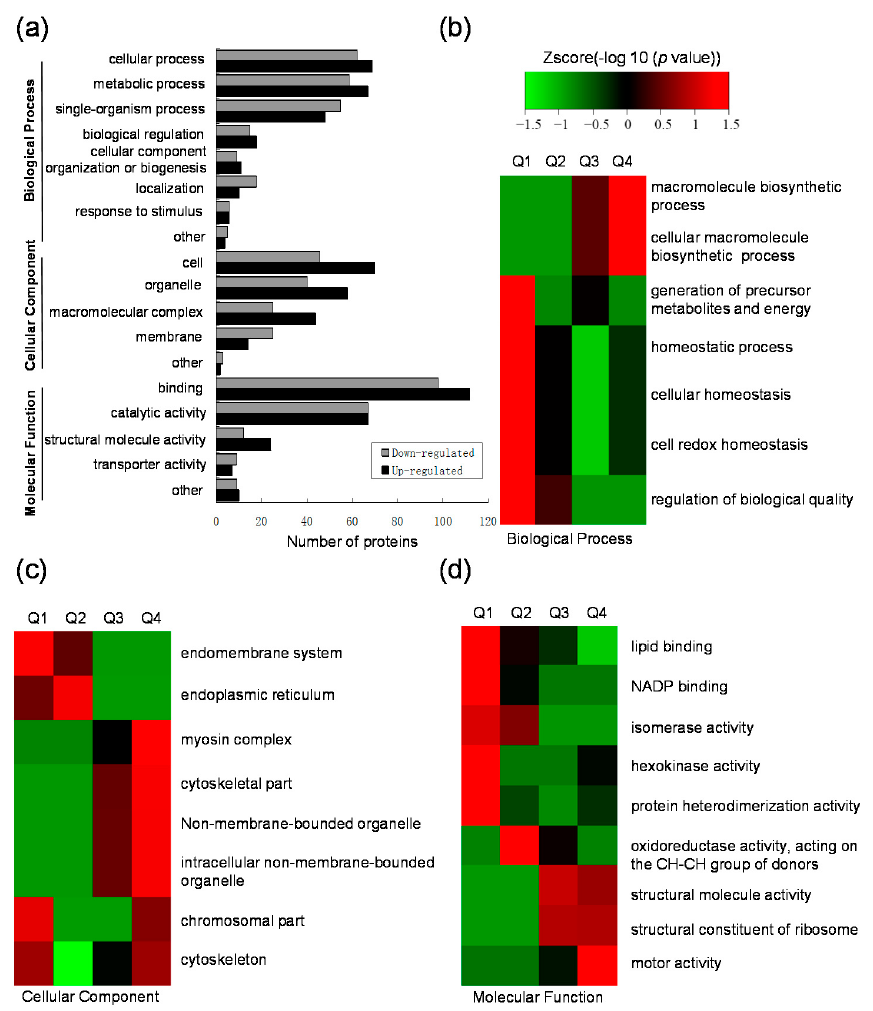
Figure 3. GO functional classification and GO enrichment-based clustering analysis for the differentially expressed lysine acetylated proteins. ( a ) GO functional classification of the up-regulated or down-regulated acetylation proteins based on gene ontology; ( b – d ) GO enrichment-based clustering analysis of the differentially expressed lysine acetylated proteins; ( b ) Biological process analysis; ( c ) Cellular component analysis; ( d ) Molecular function analysis.